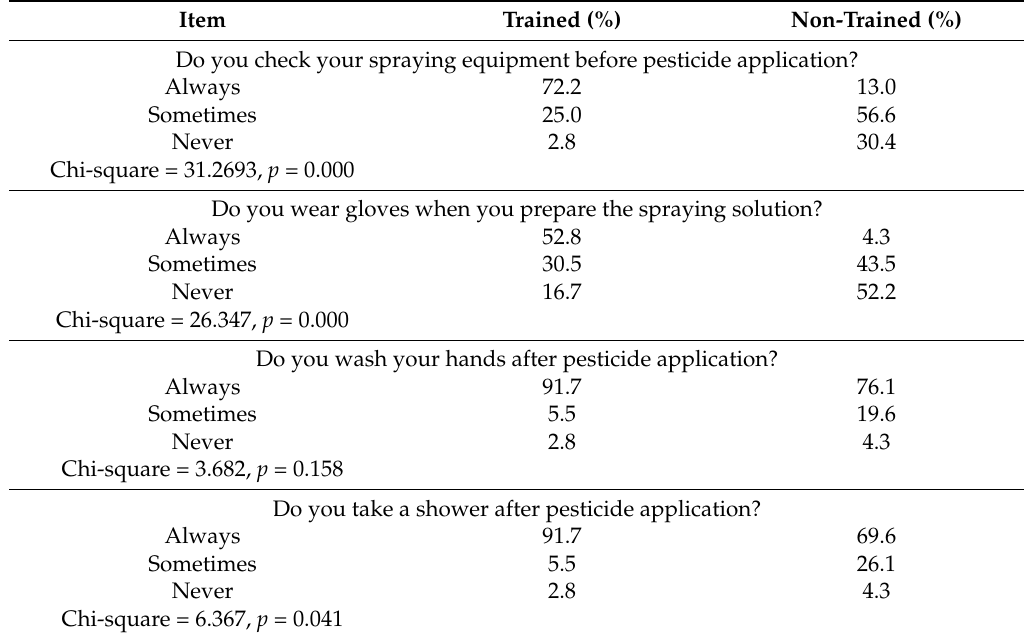
Table 4. Safety behaviors between trained and non-trained farmers.